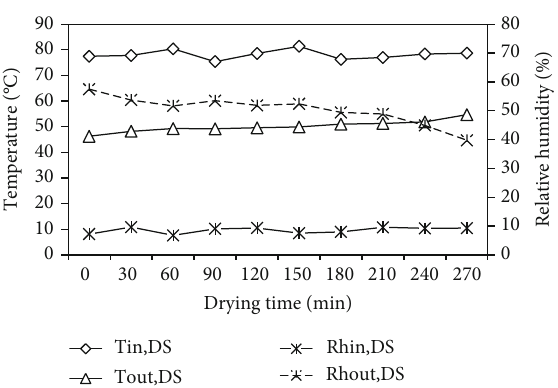
Figure 11: Variation of moisture ratio (MR) with drying time.